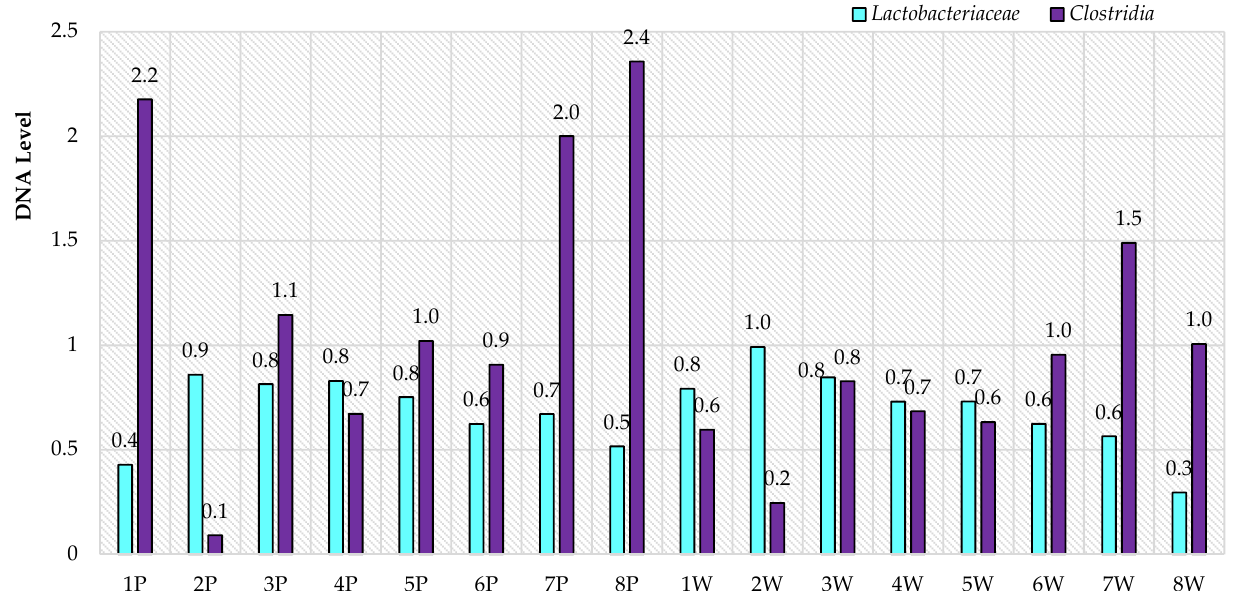
Figure 5. Individual levels of selected DNA bacterial families in the gastrointestinal tract of ewes based on feces (P— primiparous, W—multiparous).